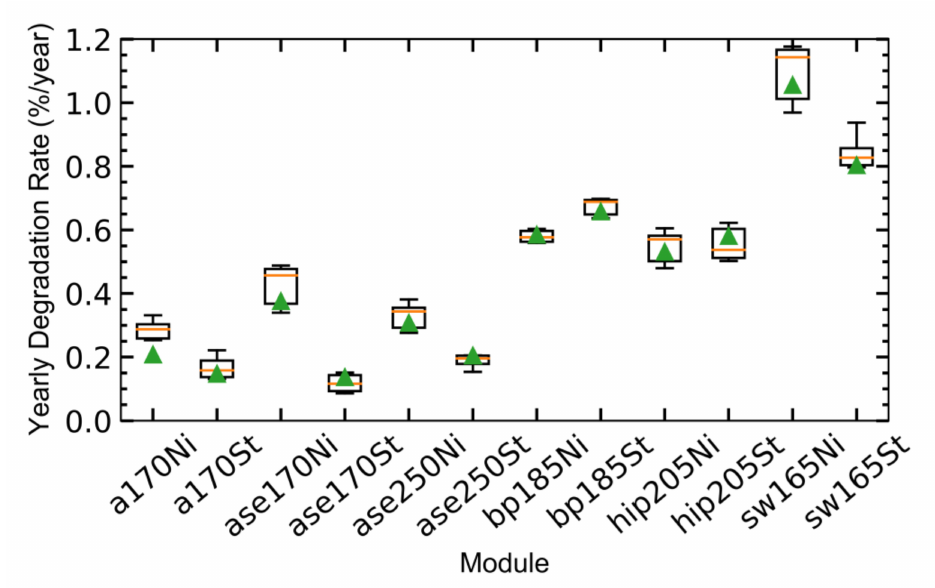
Figure 11. Box-plot of the R D of each PV system and all methods at both locations over the 12-year evaluation